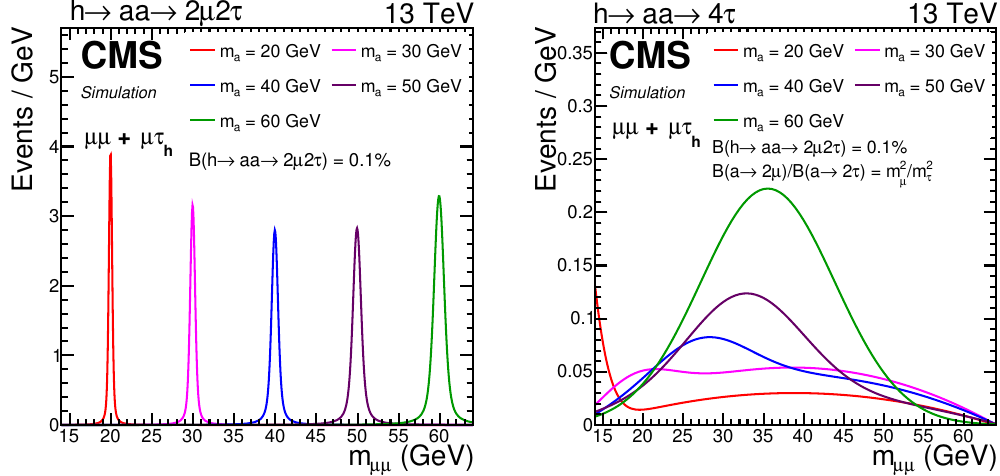
Figure 1 . Parameterized dimuon invariant mass distributions of the h ! aa ! 2 (cid:22) 2 (cid:28) (left) and h ! aa ! 4 (cid:28) (right) signal processes simulated at di(cid:11)erent m a values in the (cid:22)(cid:22) + (cid:22)(cid:28) h (cid:12)nal